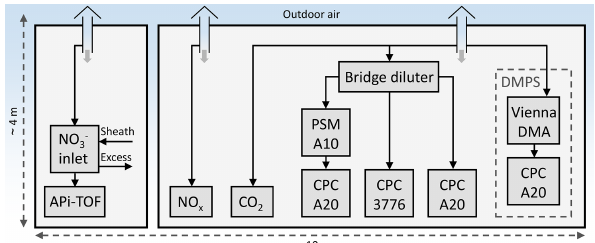
Figure 2. The measurement setup inside the containers at the curb- side of the street